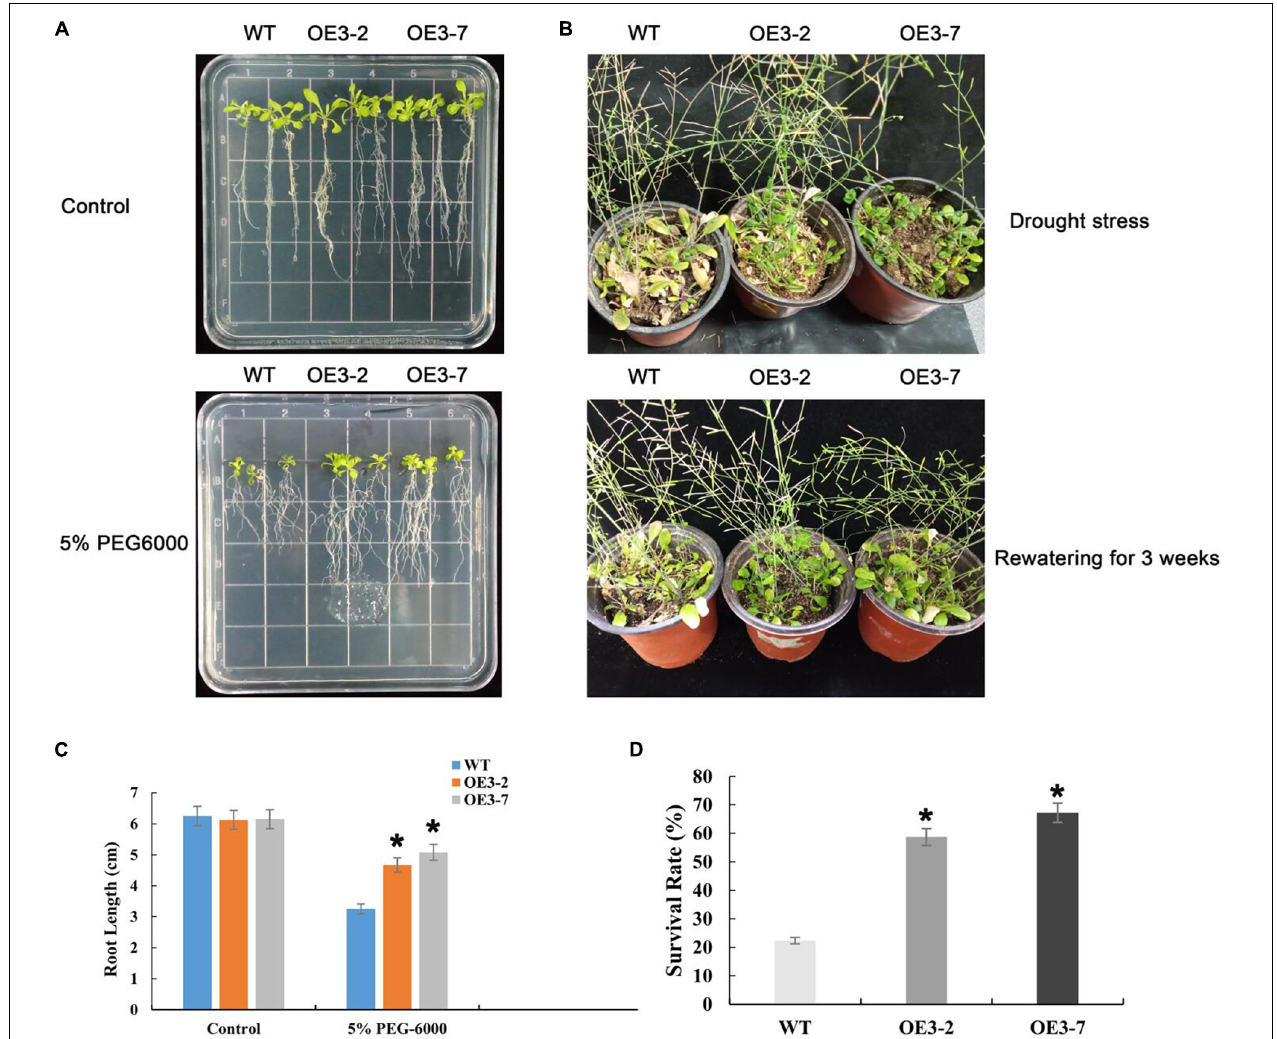
FIGURE 7 | Drought stress responses of transgenic Arabidopsis overexpressing PtOFP1. (A) Phenotypes of WT and transgenic plants grown on PEG6000 (0 and 5%) for 10 days. (B) Phenotypes of drought treatment for 15 days and rewatering for 3 weeks. (C) Root length of WT and transgenic seedlings that were transferred to medium with or without 5% PEG-6000. (D) The survival rates of Col-0, OE3-2, and OE3-7 under drought stress. The results are shown as the means ± SD of three biological replicates. Asterisks indicate a significant difference at * P < 0.05 with respect to corresponding